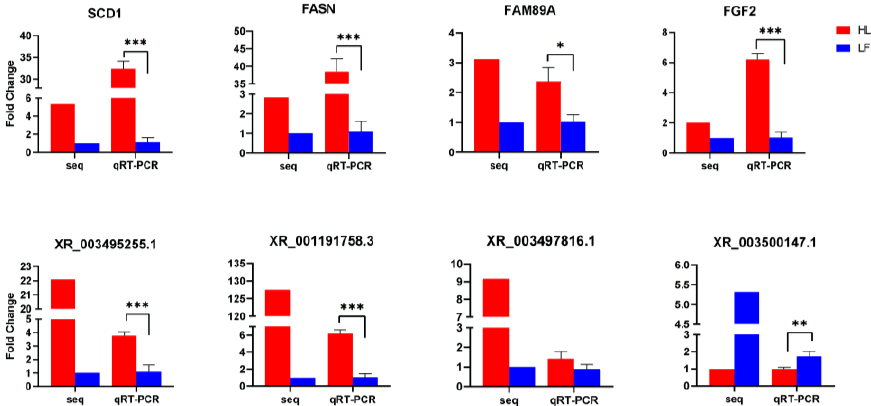
Figure 6. qRT-PCR verification of differentially expressed genes/lncRNA results. Red represents HL and blue represents LF ( 0.01< * p < 0.05, ** p < 0.01, *** p < 0.001).